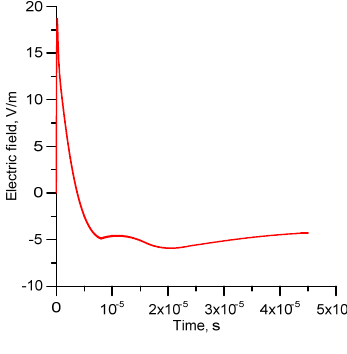
Figure 18. The same example as in Figure 17c but with the speed of propagation increased to 6 × 10 7 m / s. Note that, in this example too, the peak value at 100 km is selected to be 10 V/m. Since the peak of the radiation field increases linearly with the speed of propagation, the value of n 0 had to be reduced by half compared to Figure 17c to keep the peak radiation field at 10 V/m.